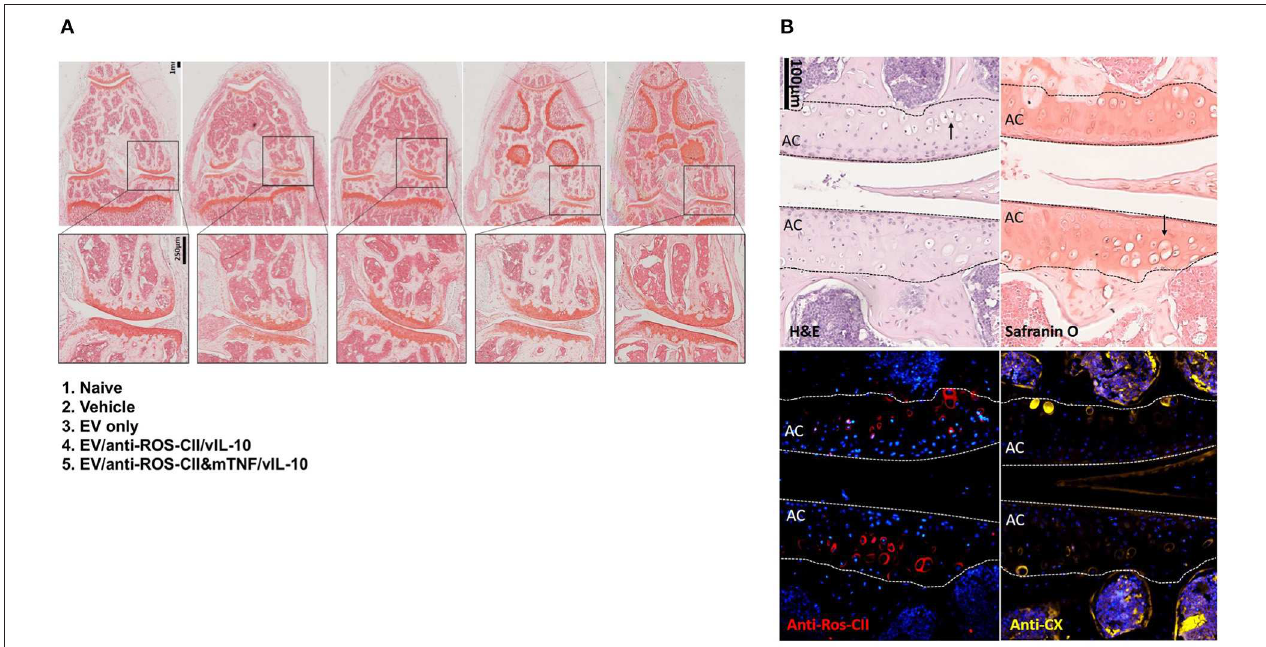
FIGURE 6 | Histological analysis of excised knee joints. Histopathology analysis of knee sections revealed a spectrum of anti-inflammatory responses. (A) Safranin O staining of example knees comparing vehicle to treatment groups which were improved to various degrees. We observed improved histological arthropathy phenotype with mice treated with EV enriched with both vIL10 and anti-TNF α which in some mice as shown in this example resemble naive phenotype. Safranin O staining of cartilage from non-treated AIA knee (vehicle) displayed weaker staining and abundant chondrocyte death. The cartilage from healthy control animals was smooth, with clear strong staining with safranin O. In the EV-treated knee, we observed areas of weak safranin O staining within the cartilage layers. (B) Examples from other groups of sections within the central region of the knee were stained with hematoxylin and eosin (H&E), safranin O, anti-ROS-CII, and anti-collagen type X. Example images show corresponding regions within the same diseased knee in the anti-ROS-CII&mTNF/vIL-10 treatment group. Chondrocyte death within the cartilage can be seen (black arrows). The presence of damaged cartilage is stained by anti-ROS-CII (oxidative post-translationally modified collagen type II neo-epitope, red). These areas corresponded with regions of chondrocyte hypertrophy indicated by staining with antibody to collagen type X (anti-CX, yellow). Lines define the boundaries of the articular cartilage